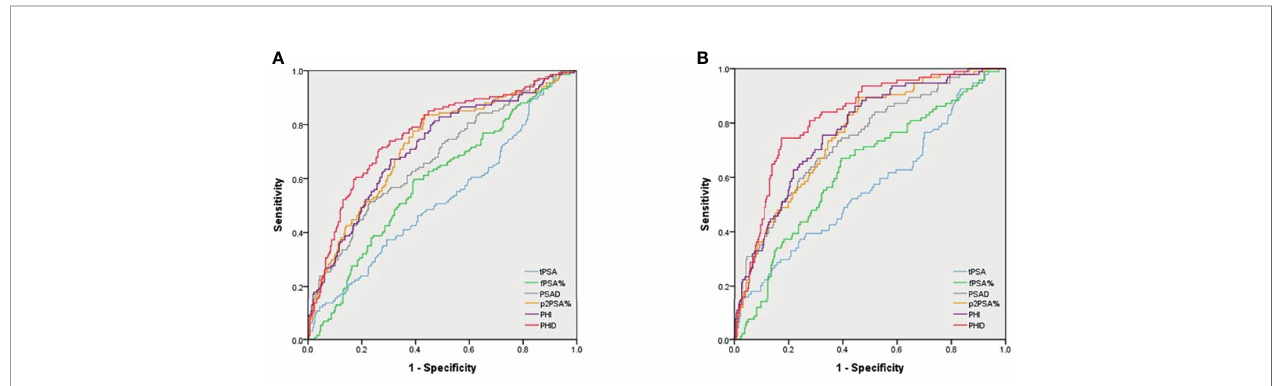
FIGURE 1 | Area under the receiver operating characteristic (AUC) curves for predicting (A) PCa and (B) csPCa. (A) AUC for PCa detection were as follows: PSA 0.53, % fPSA 0.59, PSAD0.68, %p2PSA 0.72, PHI 0.72 and PHID 0.77, respectively. (B) AUC for csPCa detection were as follows: PSA 0.56, %fPSA 0.63, PSAD 0.74, %p2PSA 0.76, PHI 0.77 and PHID 0.82, respectively. The AUC diagnostic effect of PHID is still signi fi cantly better than PHI in PCa or csPCa ( p = 0.007 and 0.004, respectively).